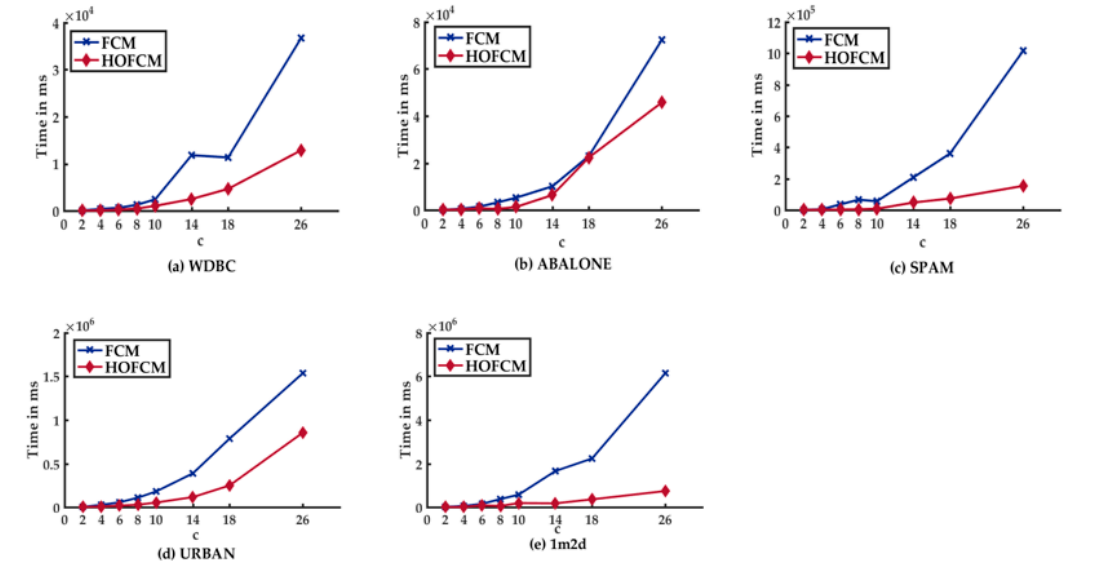
Figure 4. Results of the clustering in Experiment I.